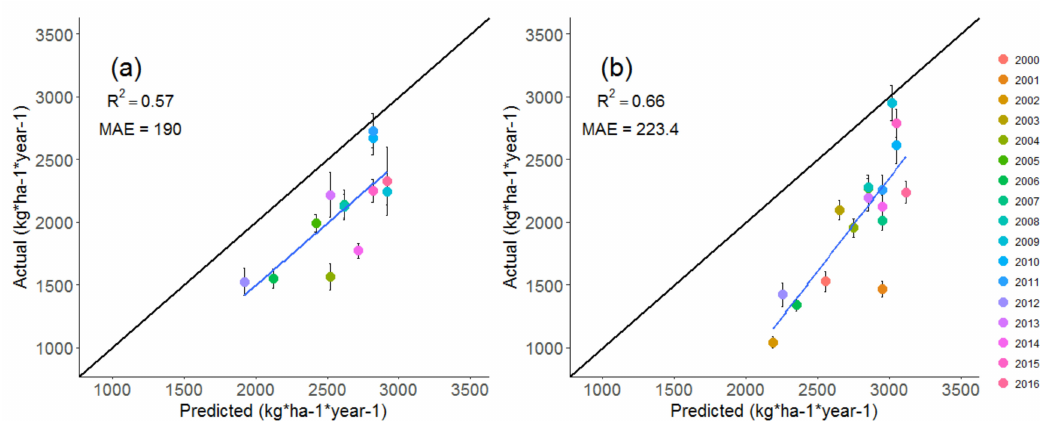
Figure 7. Scatter plots for two locations of ground-based validation collected at the Gudmundsen Sandhills Laboratory ( a ) and the Barta Brothers Ranch ( b ). Clipping data (actual) are represented on the x-axis and modelled data (predicted) are on the y-axis. Each year of data collection (2000–2016) is represented by one data point (Gudmundsen data starting with the year 2004). The blue line represents regression and the black line is the 1:1 relationship between actual and predicted biomass. Error bars are based on variation between sampling locations for each